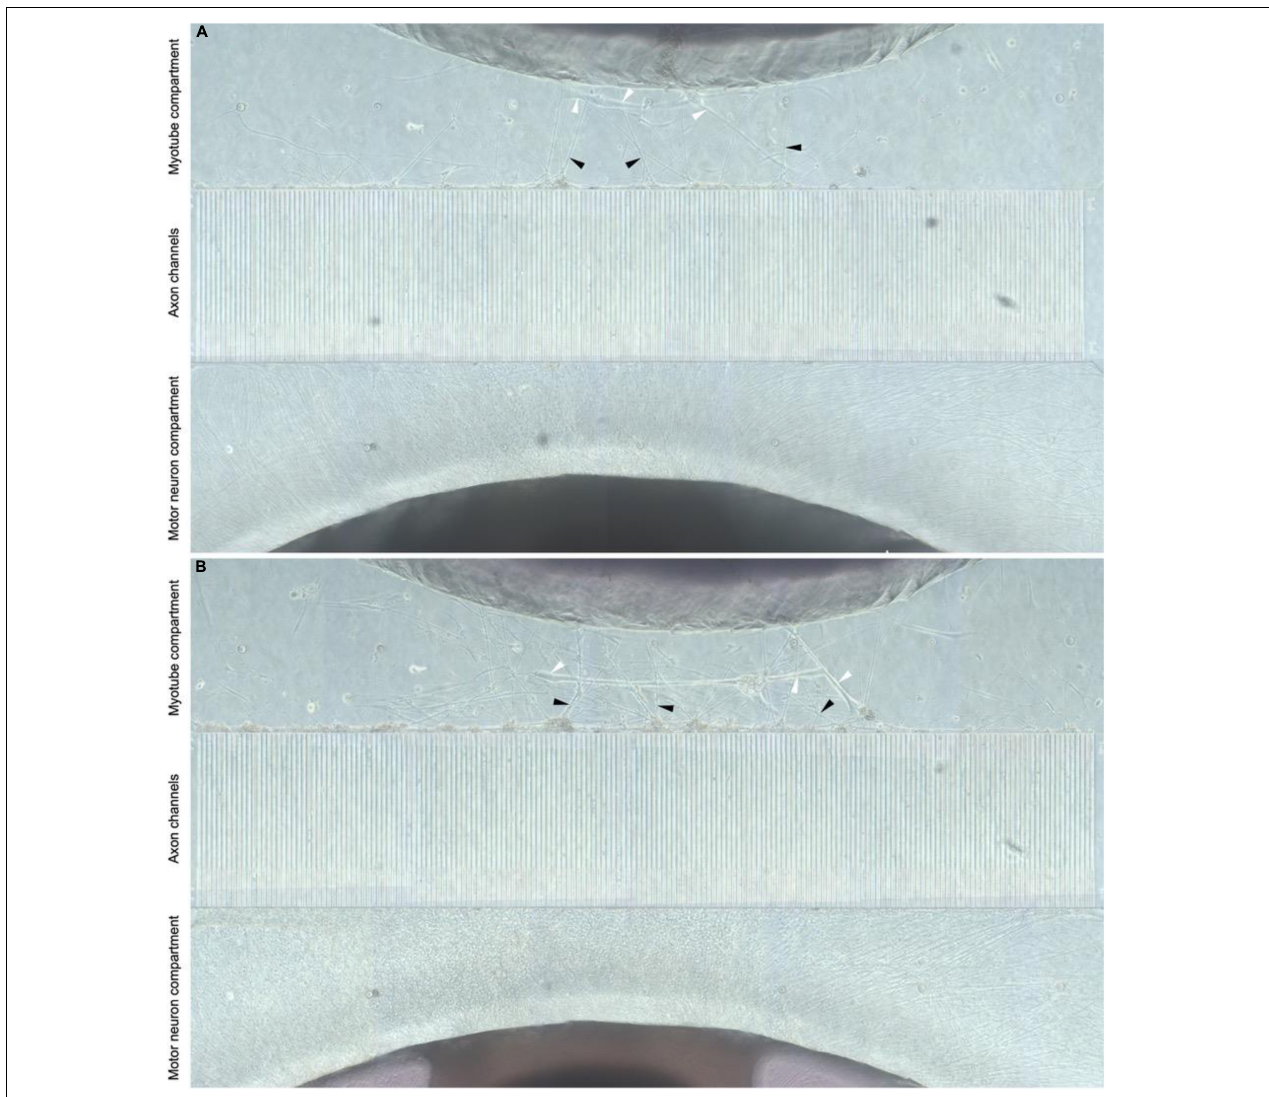
FIGURE 4 | Directional MN axon outgrowth into the myotube compartment. Representative image from the microfluidic chips at 8 and 21 DIV ( A,B , respectively), showing directional axonal outgrowth from the MN aggregate into the axon tunnels and entry into the opposite compartment containing myotubes. MN neuron axons (black arrows) are clearly visible and appear to contact myotubes (white